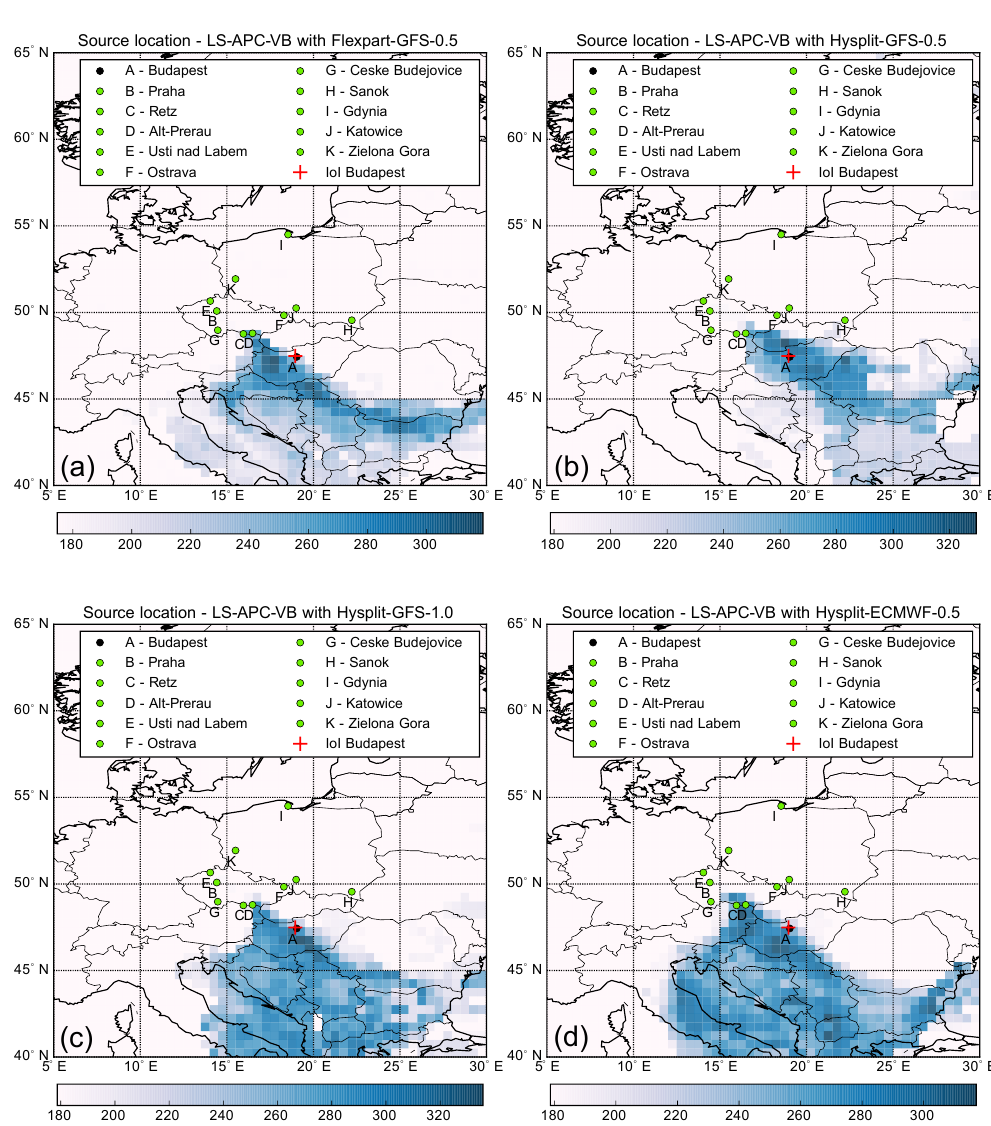
Figure 8. Sensitivity study of the source location using measurements without the Budapest station. Marginal log-likelihood that the observed data are explained by a release from a grid cell using the LS-APC-VB algorithm for each tested combination of dispersion model and meteorological data: Flexpart-GFS-0.5 (a) , Hysplit-GFS-0.5 (b) , Hysplit-GFS-1.0 (c) , and Hysplit-ECMWF-0.5 (d) . The measuring sites (see Table 1) are displayed using green circles while the location of the Institute of Isotopes (IoI) Ltd. is displayed using a red cross and the excluded measuring station Budapest (denoted by A) is displayed using a black